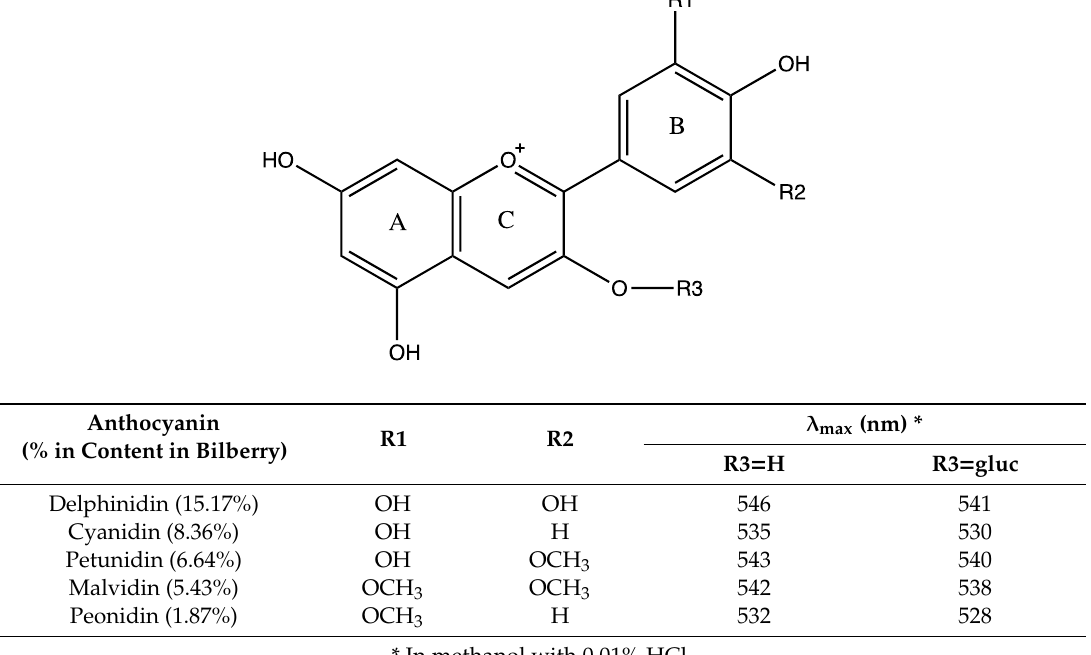
Figure 1. Structures of the main anthocyanin-3- O -glucosides found in bilberry and respective wavelength at the maximum absorption in the visible region ( λ max ). Note that anthocyanins have characteristic colors, but the color of anthocyanins can change with the pH of the solution [11,20]. The usual dietary intake of anthocyanins is approximately 200 mg daily [25]. Anthocyanins, unlike other polyphenolic flavonoids, are absorbed rapidly in the intact glycosidic form and do